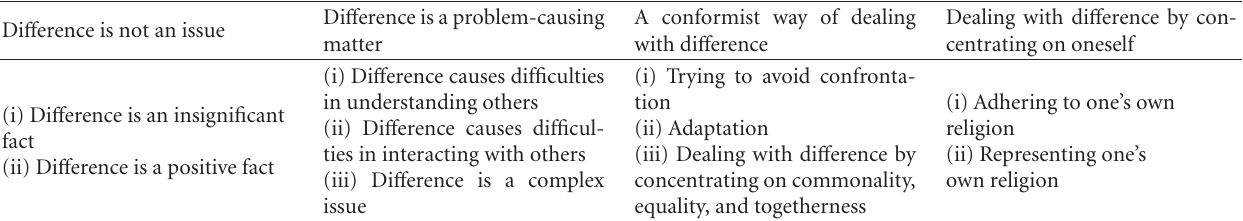
Table 1: Ways of perceiving and dealing with di ff erence related to the negotiation of liberal ideals. Di ff erence is not an